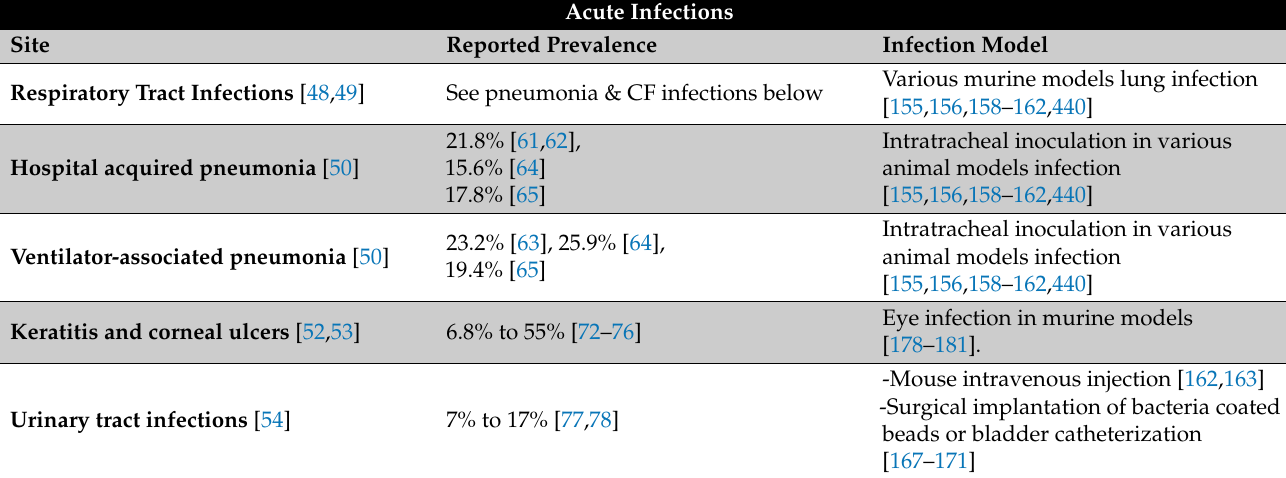
Table 1. Pseudomonas aeruginosa infection types, prevalence, and animal